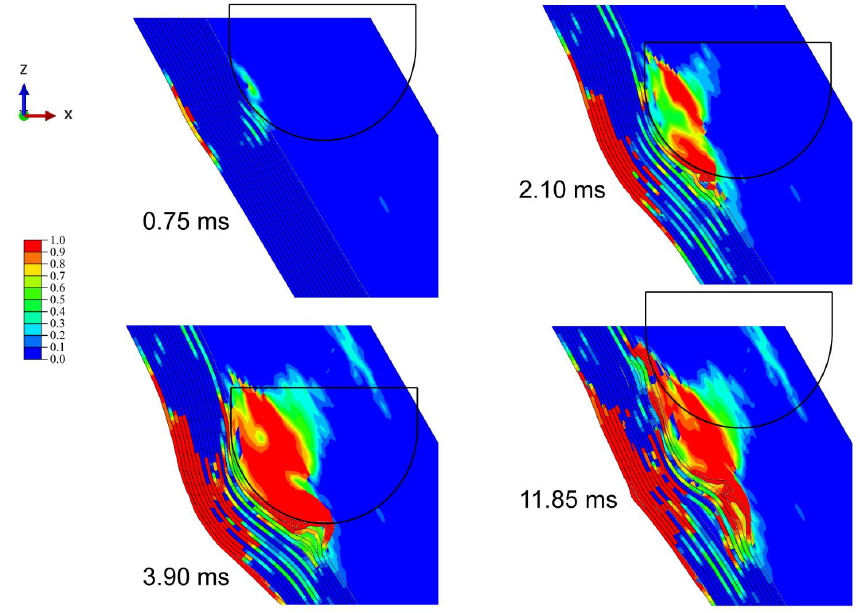
Figure 8. Evolution of matrix tensile damage with 60° impact angles under 20 J impact energy.